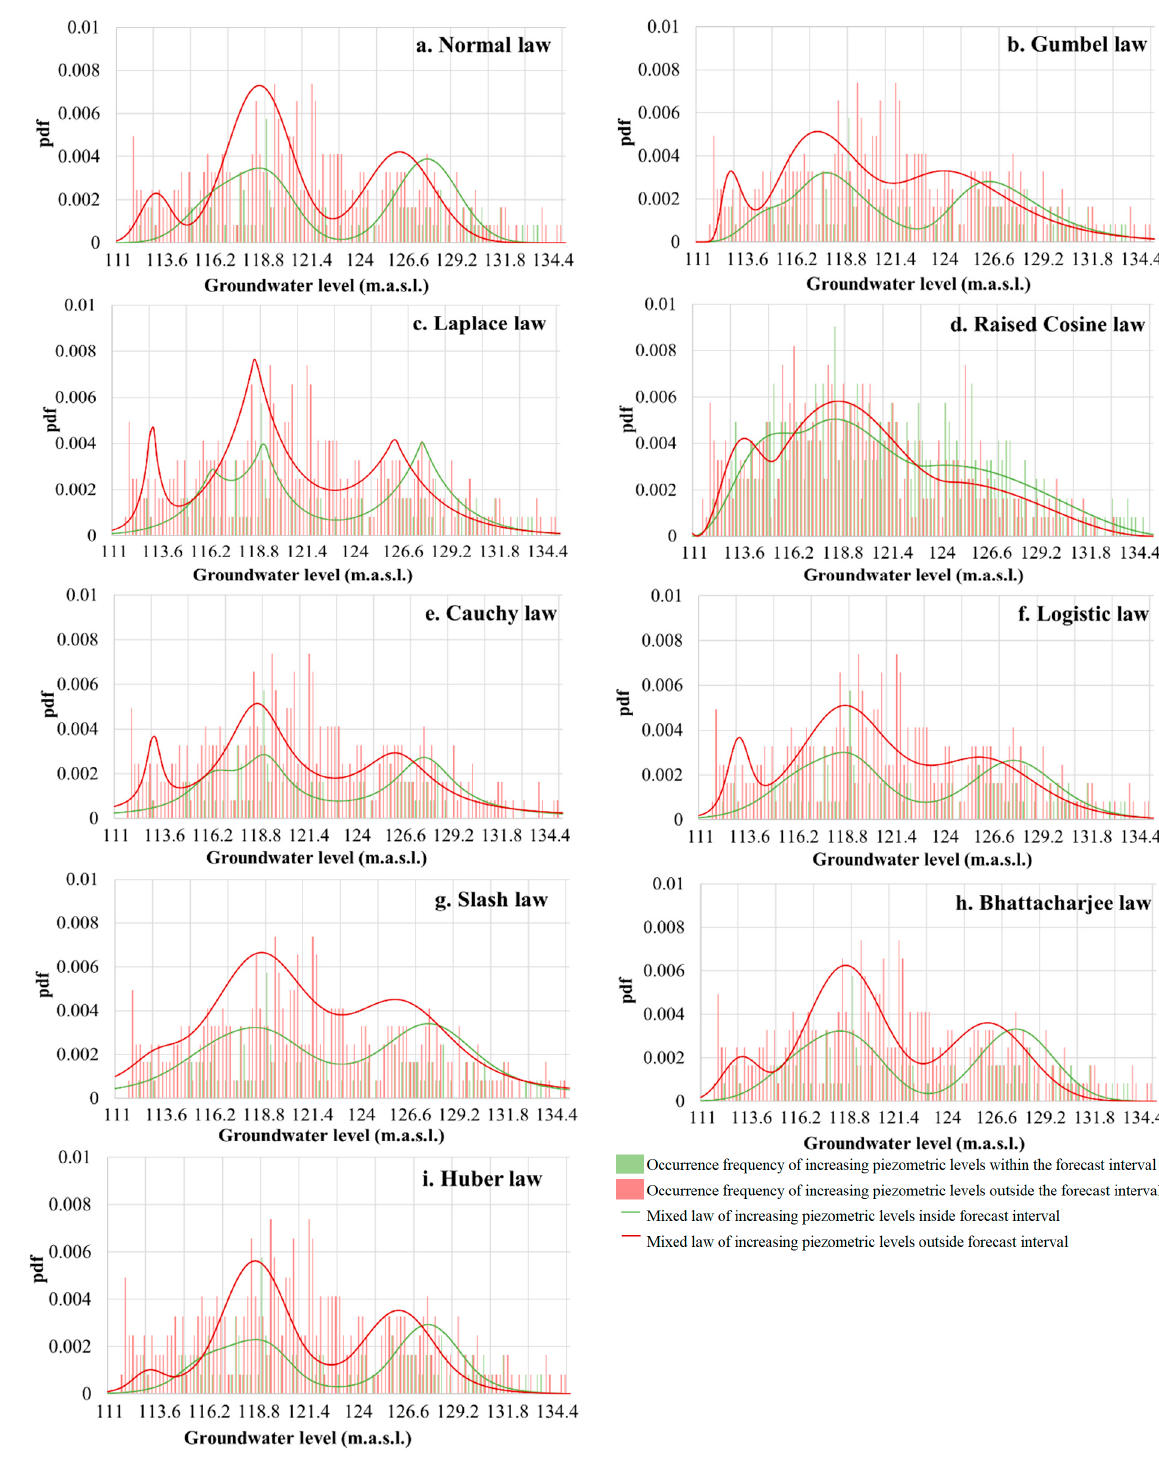
Figure 9. Mixed pdf for increasing groundwater distributions. with ( a ) Normal law, ( b ) Gumbel law, ( c ) Laplace law, ( d ) Raised Cosine law, ( e ) Cauchy law, ( f ) Logistic law, ( g ) Slash law, ( h ) Bhattacharjee law and ( i ) Huber law.